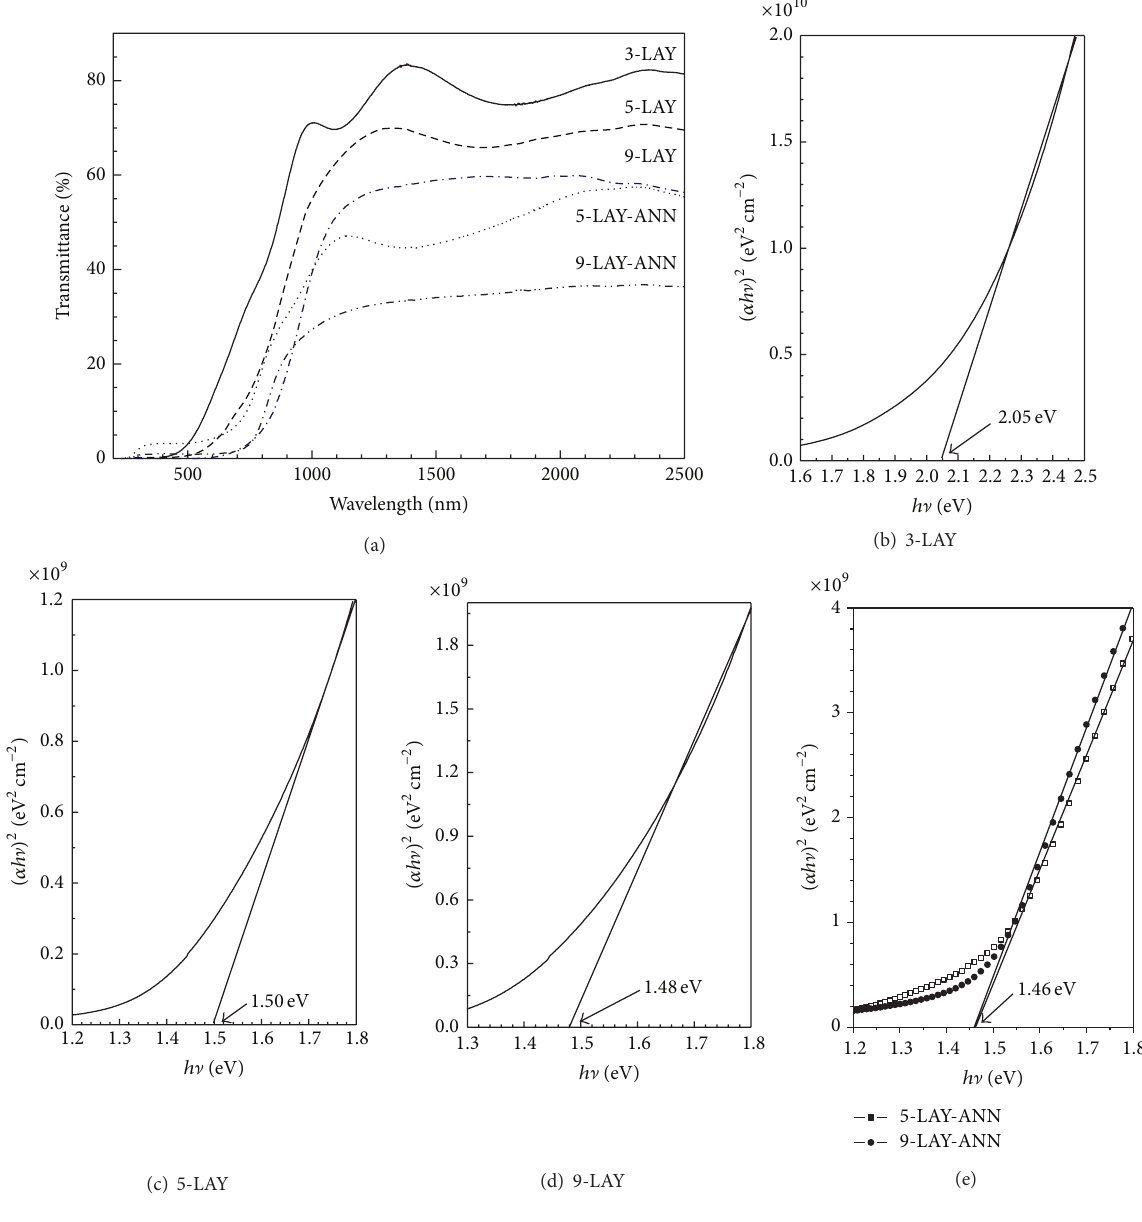
Figure 3: (a) Transmittances of CZTS films. (b)–(e) Tauc curves of CZTS films.